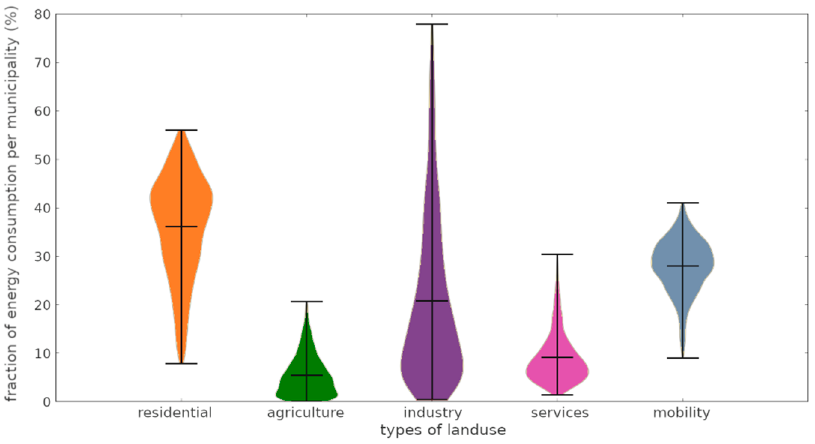
Figure 6. The significance of land use types for the municipalities´ energy consumption: Average, minima and maxima share as well as the frequency distribution.